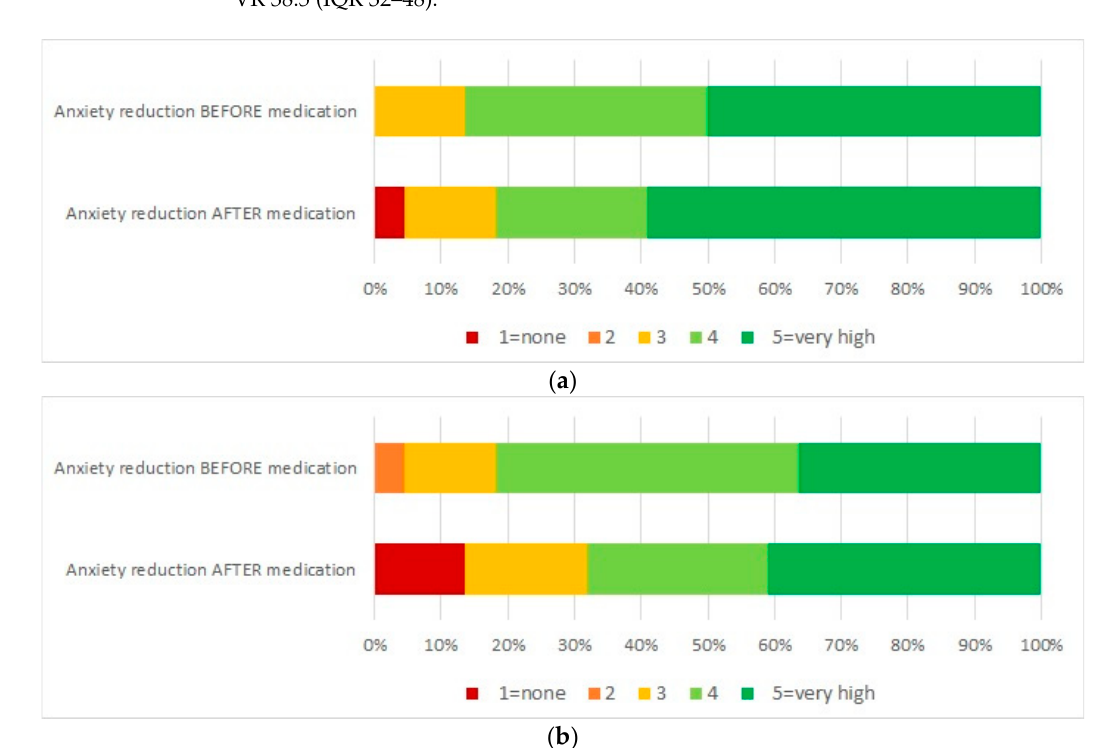
Figure 3. Perceived efficacy of VR by families and children ( a ) families; ( b )